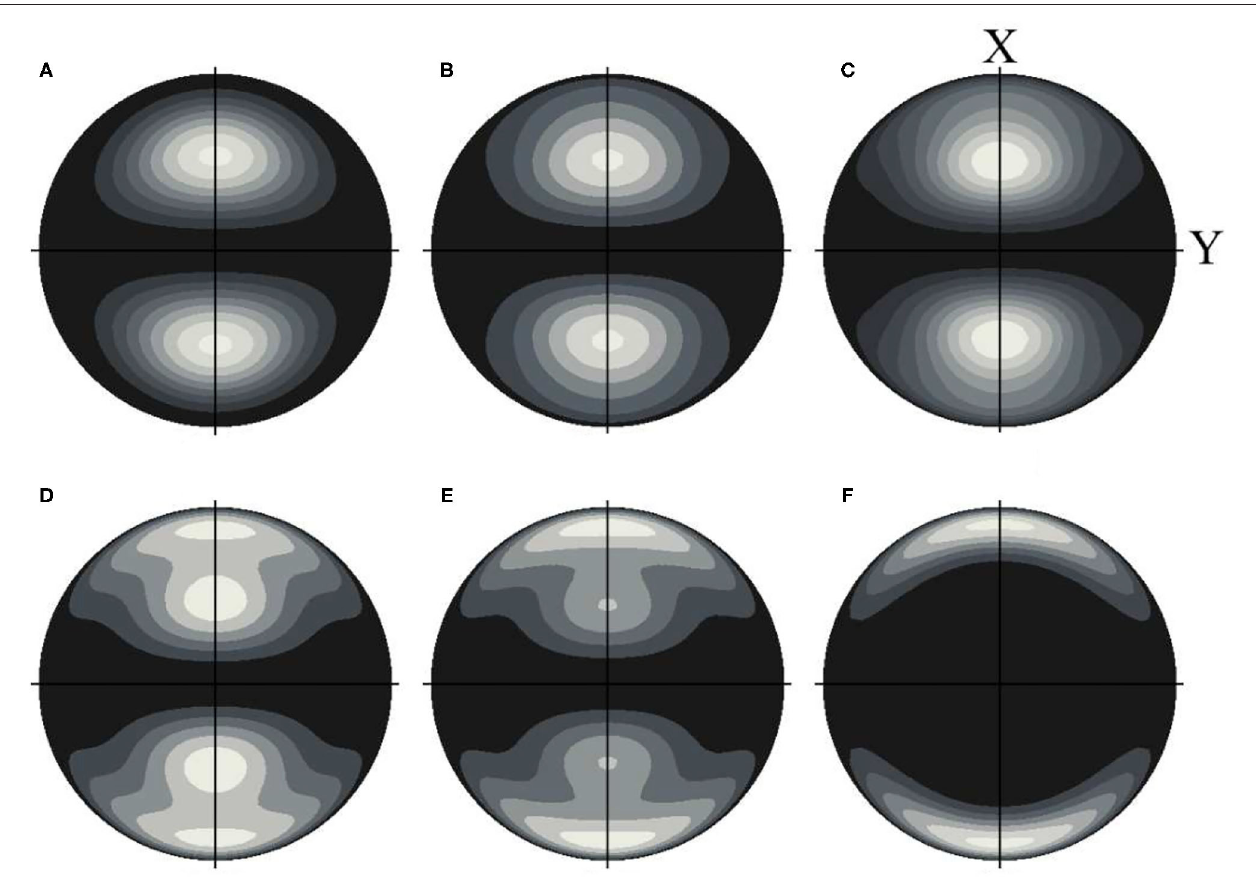
FIGURE 4 | Scattering images of rotationally relaxed HD ( v j f S J = 2 ( j 2, l 2 0, l f 2 ) (see Supplementary Material ). From (A)–(F) , the six images are calculated using phases of 0, 0.6 π , 0.65 π , 0.75 π , 0.8 π , and π = = ; = =